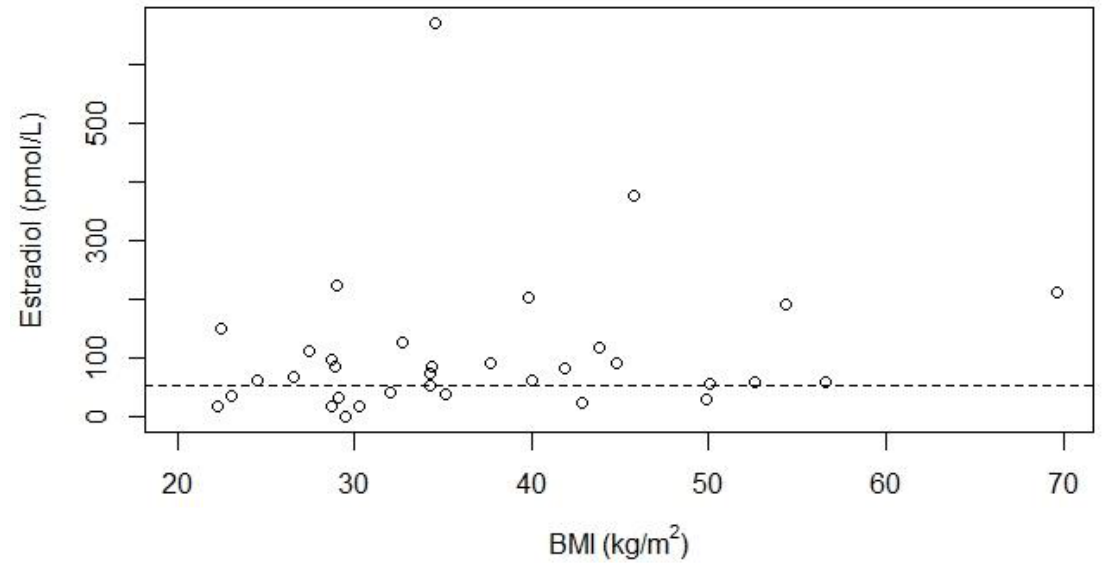
Figure 1. Relationship between serum estradiol concentrations and BMI for 34 women with Prader-Willi syndrome. Abbreviations: body mass index (BMI). The dotted line represents the lower limit of normal for estradiol of 55 pmol/L. Thirty-three women included in this figure had hypogonadism. One woman did not have hypogonadism as she had a regular menstrual cycle, she had an estradiol value of 41 pmol/L. The p -value for the relationship between estradiol and BMI was 0.13, Kendall’s Tau was 0.18.